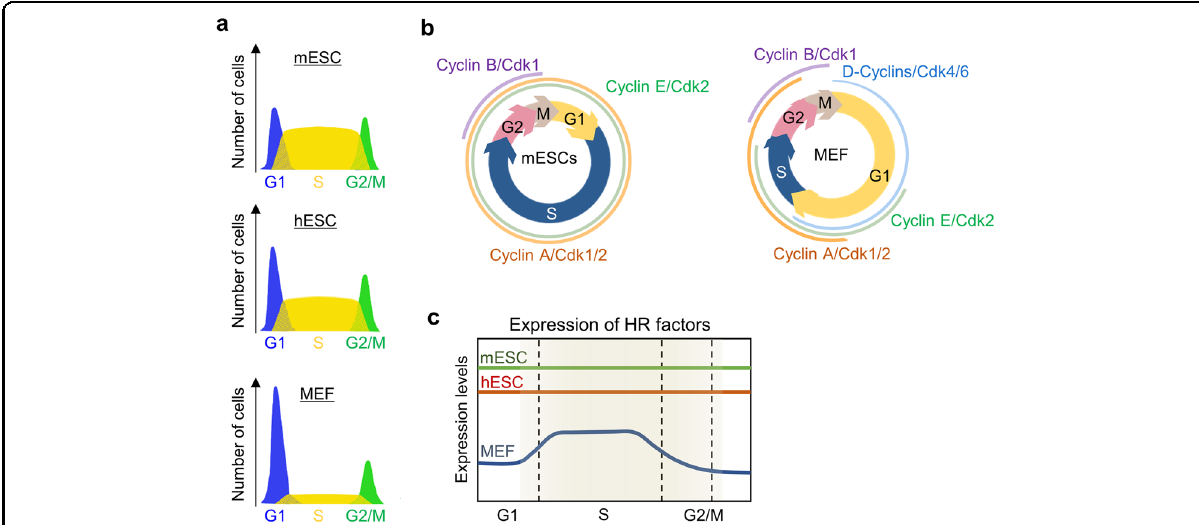
Fig. 1 The cell cycle in ESCs and MEFs. a Comparison of the cell cycle patterns of embryonic stem cells (ESCs) and mouse embryonic fi broblasts (MEFs). General cell cycle pro fi les of ESCs (mESCs and hESCs) and MEFs are shown. b Differences in the expression of cell cycle components in mESCs and MEFs. In contrast to MEFs, mESCs continuously express cyclin A/E but lack the expression of cyclin D. This allows ESCs to retain retinoblastoma (Rb) hyperphosphorylation throughout the cell cycle, resulting in a rather short G1 phase. c Expression pattern of HR-related proteins between mES cells and MEFs. In the entire cell cycle, HR proteins are highly expressed in ESCs but not in